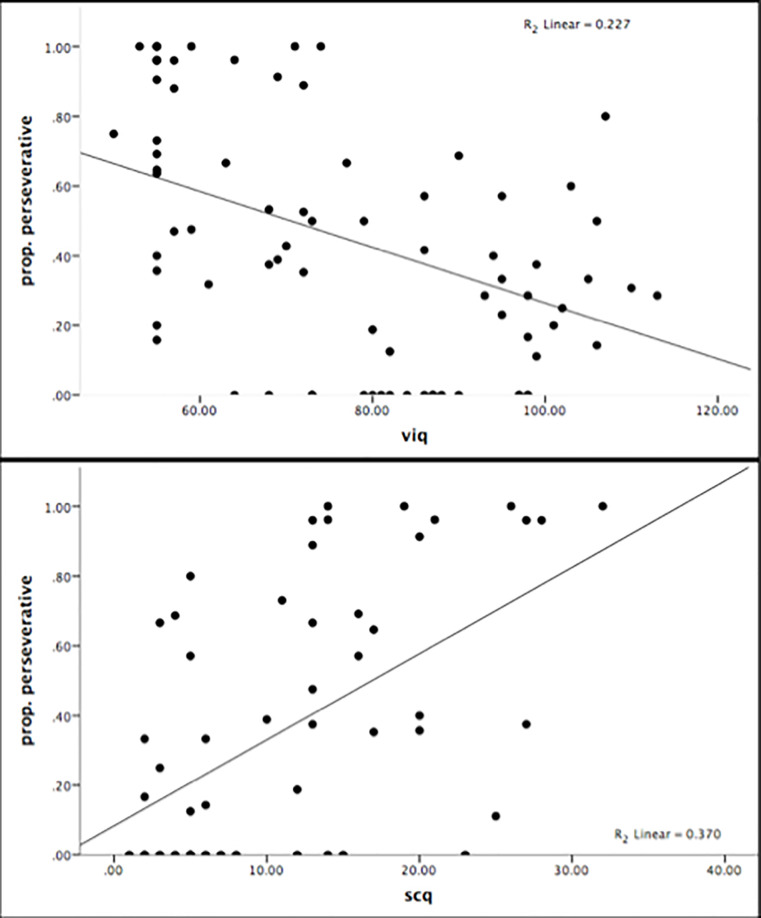
Scatterplot of the relationship between proportion of perseverative errors and VIQ (top) and SCQ (bottom).